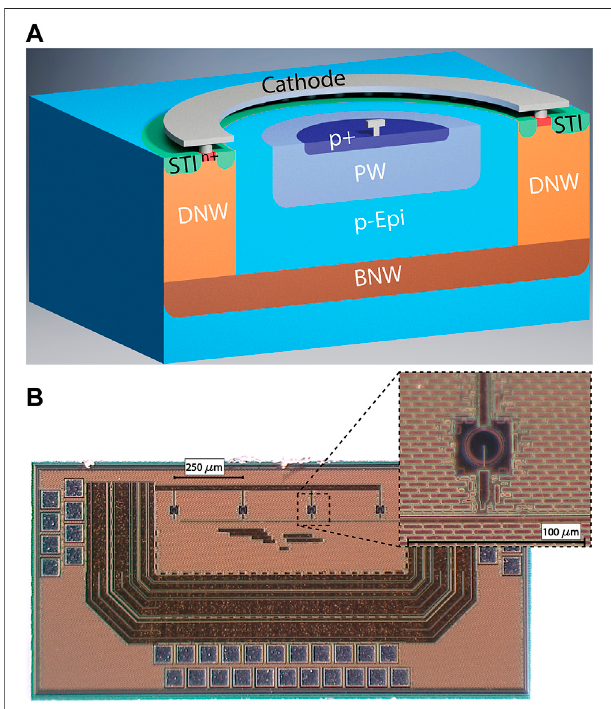
FIGURE 1 | (A) : SPAD cross section. (B) : Micrograph of the implemented chip embedding 25 μ m diameter SPADs with integrated pixel circuit [21].